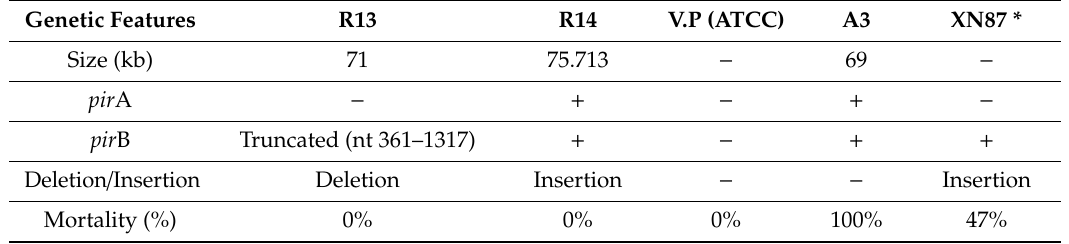
Table 1. Genetic features of the plasmid DNA carrying binary toxin gene in the Vibrio parahaemolyticus reference strain, A3, and the mutant strains R13 and R14. A recently described mutant strain of V. parahaemolyticus, XN87, that carries one of the two toxin genes but causes mortality in Penaeus vannamei shrimp is included for comparison